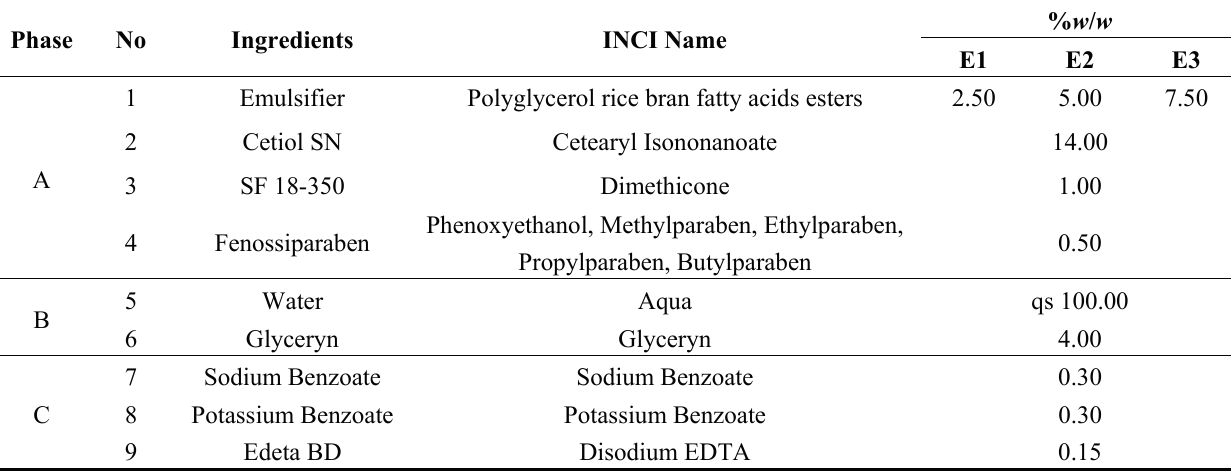
Table 1. Composition of O/W basic emulsions containing a different percentage of emulsifier.